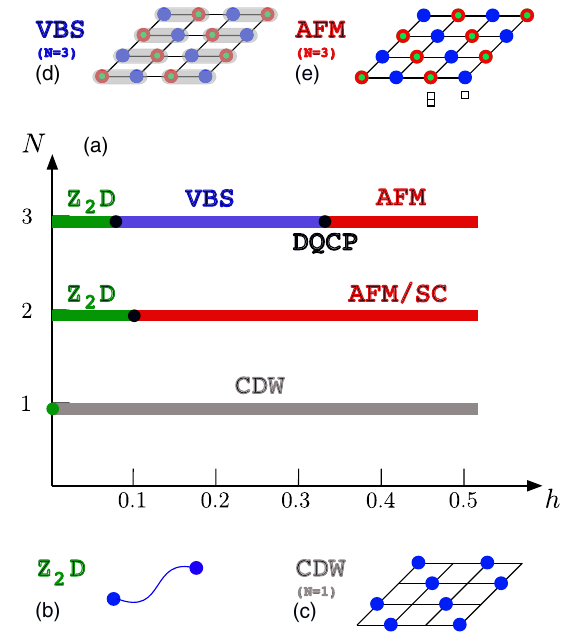
FIG. 1. Schematic zero-temperature phase diagram of the model in Eq. (1) (a), as well as cartoons (b) – (e) of a selected number of phases. (a) We observe a Z 2 Dirac deconfined phase ( Z 2 D), a N é el antiferromagnet phase (AFM) [or a superconductor (SC), depending on the pattern of particle-hole symmetry break- ing], a charge density wave (CDW) phase, and a valence-bond solid (VBS). For N ¼ 1 , we do not find evidence for a Z 2 D phase beyond h ¼ 0 , consistent with the arguments in the main text. The phase transitions from the Z 2 D to AFM/SC ( N ¼ 2 ) and VBS ( N ¼ 3 ) are seemingly continuous. At N ¼ 3 , we observe a deconfined quantum critical point (DCQP) between the VBS and AFM phases. (b) – (e) Cartoons of the corresponding phases. Circles correspond to fermions, and the color code corresponds to the flavor index. Circles with two colors represent a pair of fermions on a site with corresponding flavors. The low-energy properties of the Z 2 D phase resemble SU ð N Þ fermions propa- gating freely in space-time and connected by a Z 2 gauge string (b). The symmetry-broken phases correspond to the confined phases of the model. At N ¼ 3 , the AFM phase (e) has the fundamental (conjugate) representation of SU(3) on sublattice A (B). The corresponding Young tableaux are included. The VBS phase (d) corresponds to a pattern of intersite SU(3)